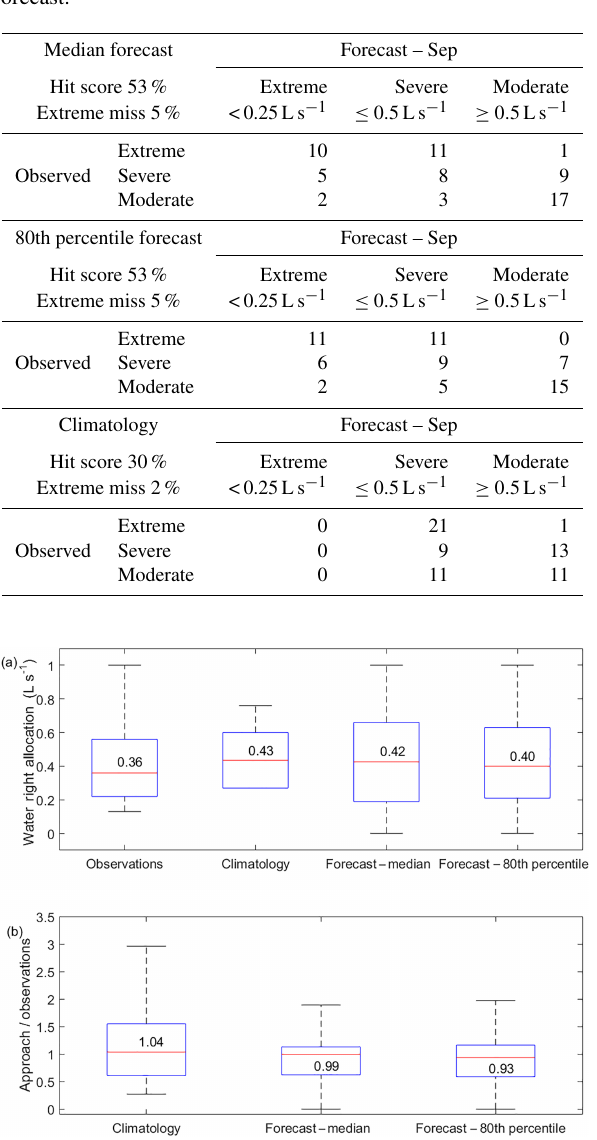
Figure 8. Reservoir model-derived forecast allocations: (a) absolute allocation values and (b) ratio of forecast allocations to observed